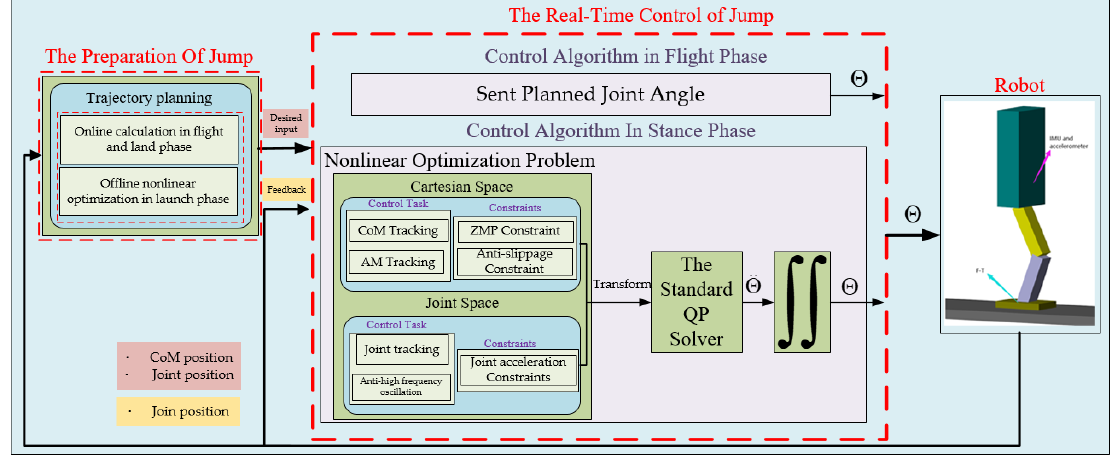
.. Figure 2. Control block diagram of robot; Θ and Θ  are the actuated joint angle and acceleration vector, respectively. Θ are the actuated joint angle and acceleration vector, Figure 2. Control block diagram of robot; Θ and